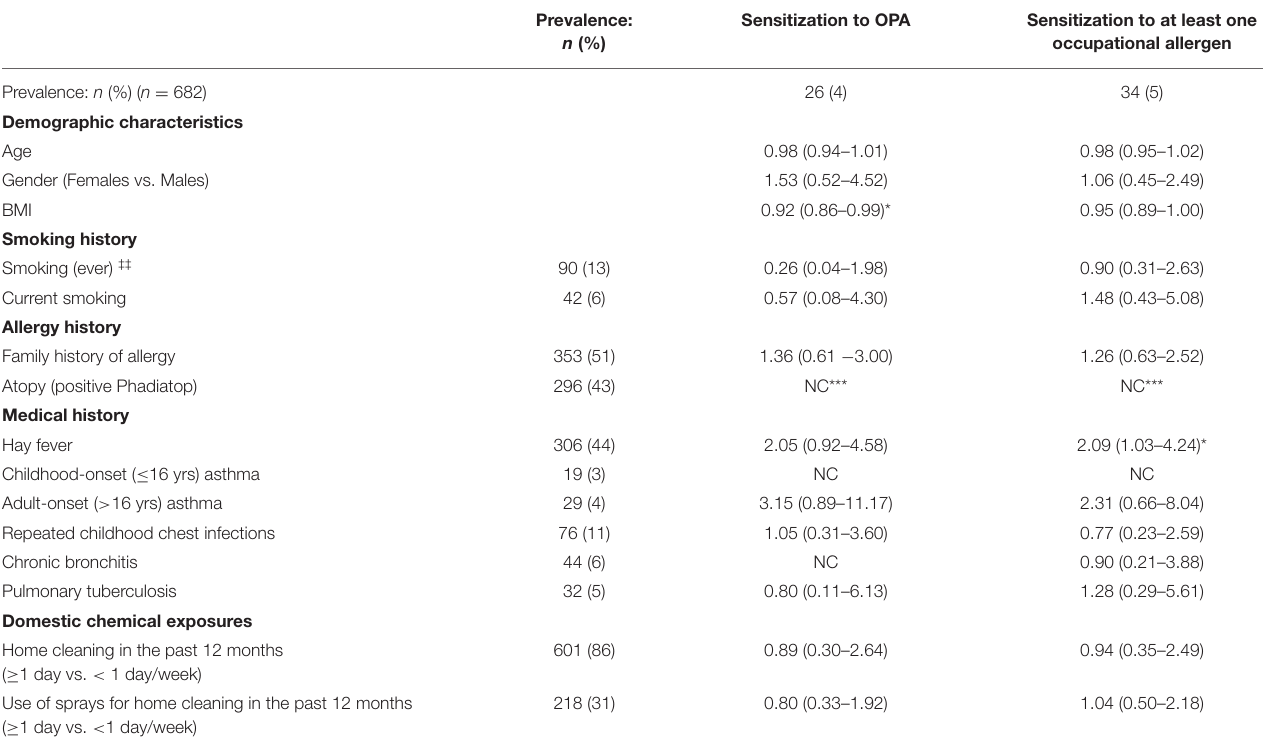
TABLE 5 | Host risk factors associated with allergic sensitization to occupational allergens among health working with cleaning agents.